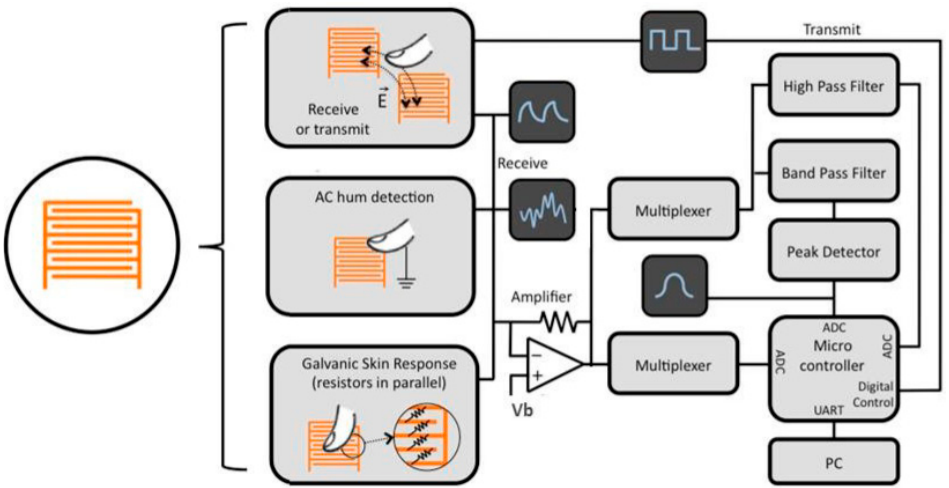
Figure 7. PrintSense: Three different signal-detection schemes (redrawn from [66]). From top to bottom: active transmit-and-receive capacitive sensing for proximity and folding detection, alternating-current hum detection for touch and proximity detection and galvanic skin response.